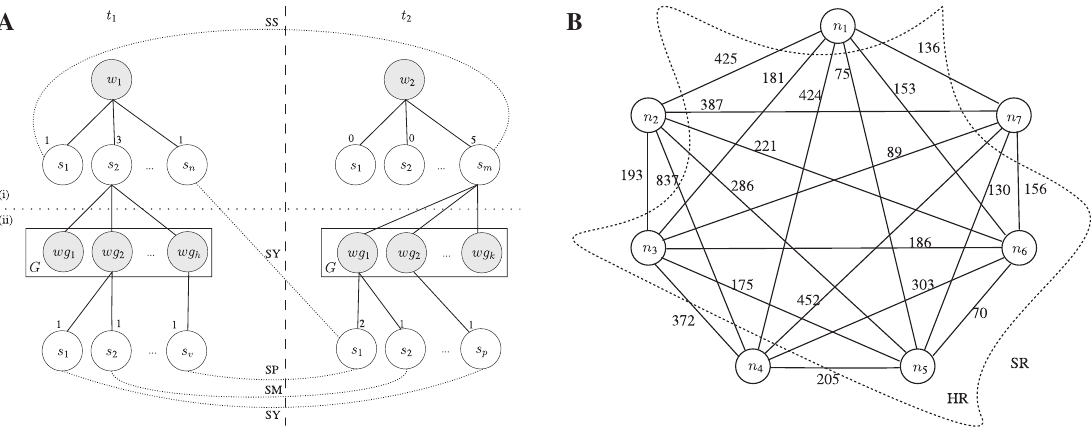
Figure 1: The conceptual shapes to visualize the relationships and information in (A) WordNet-Based Trees t 1 and t 2 , Created for Words w 1 and w 2 . (B) Graph G Build on the WSD Output for ̂︀ M ( D i ), with the Cuts by METIS